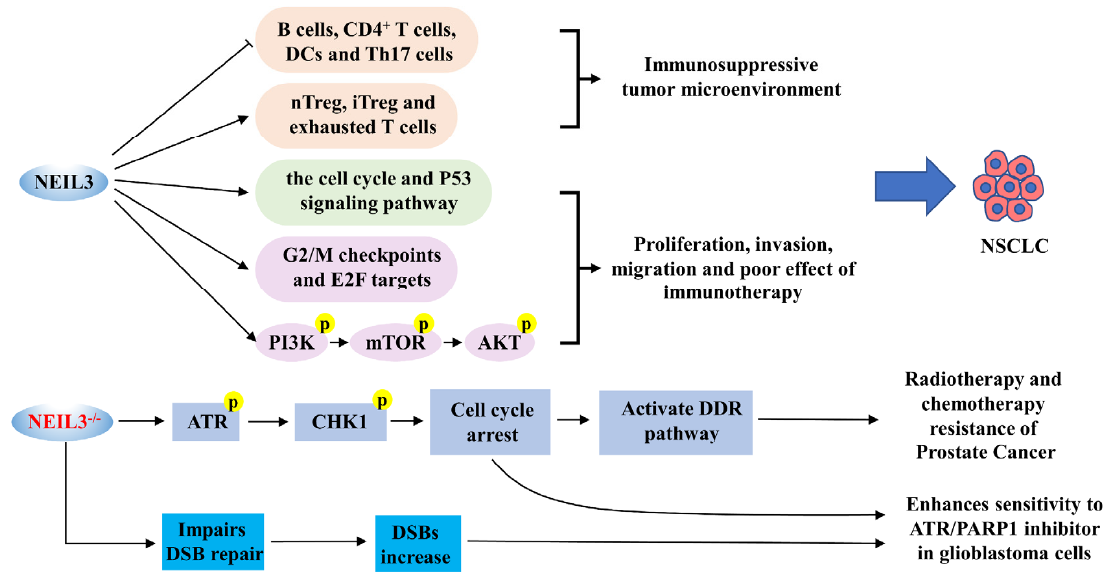
Figure 4. A schematic diagram of NEIL3 and the progression of NSCLC, prostate cancer and GBM. NEIL3 promotes NSCLC proliferation, invasion and migration by inducing the formation of an immunosuppressive tumor microenvironment, accelerating the cell cycle, and activating P53 and PI3K/AKT/mTOR pathways. The deficiency of NEIL3 significantly activates the ATR/CHK1 axis, which attenuates DNA damage by initiating the DDR pathway, ultimately conferring resistance to radiation or chemotherapy in prostate cancer cells. Nevertheless, NEIL3 deficiency increases the sensitivity of GBM cells to ATR inhibitors and PARP1 inhibitors.